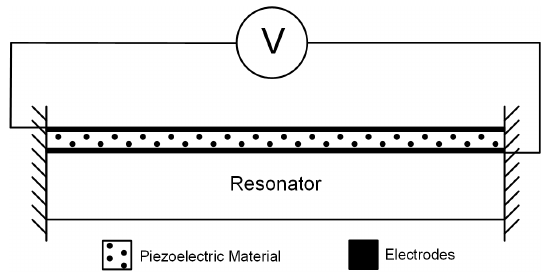
Figure 3. Schematic of piezoelectric transduction on an MEMS